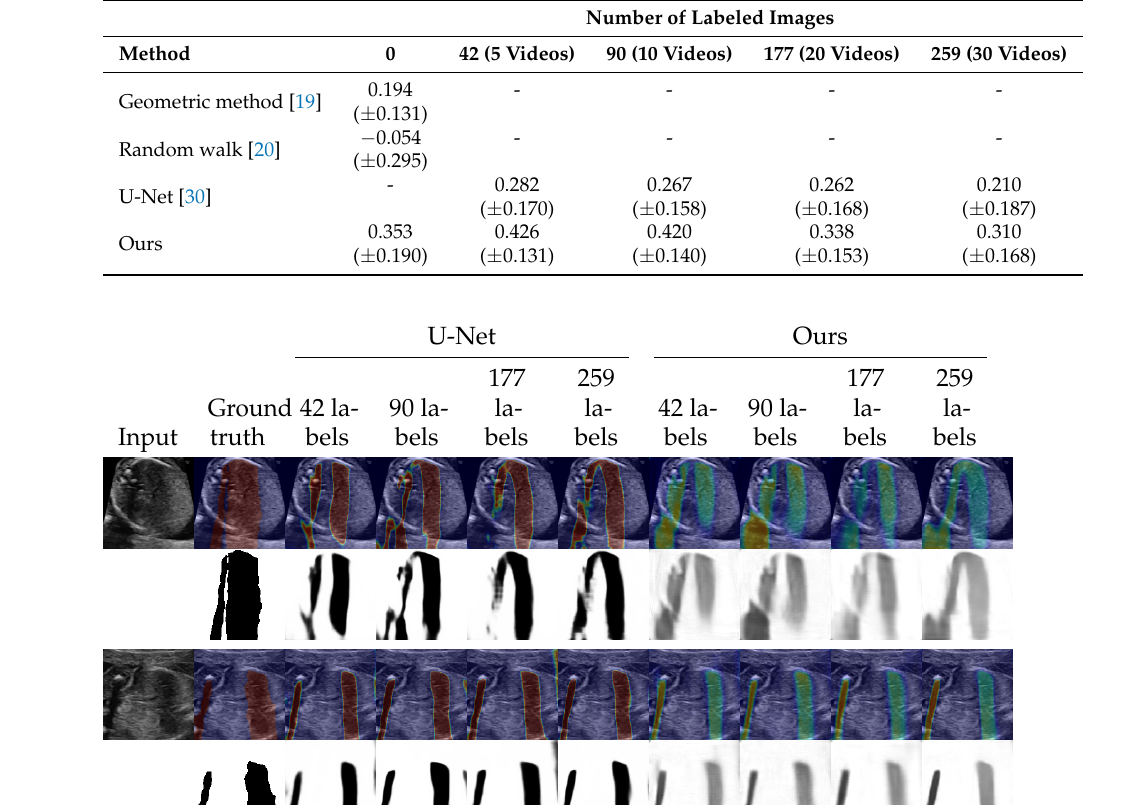
Table A3. Evaluation of the estimation of shadow intensities for the validation dataset. Scores are the correlation coefficient calculated by Equation (15). The coefficients are calculated for each validation image, and means over them are shown. The numbers in parentheses are the standard deviations.